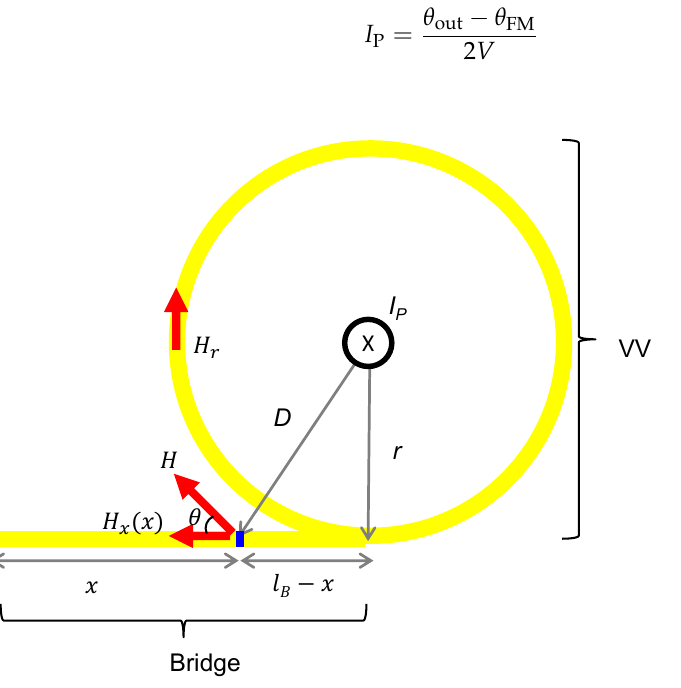
Figure 2. Shape assumption of the VV and the bridge structure for magnetic field